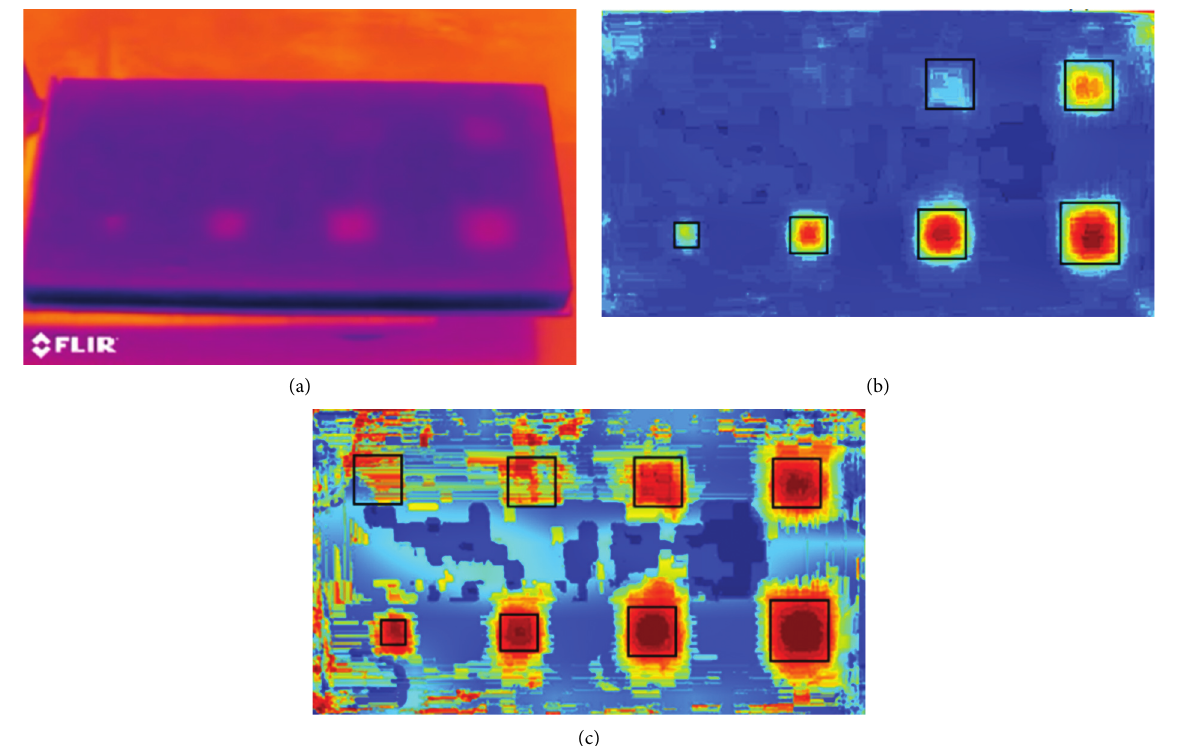
Figure 11: Comparison image enhancement of B. (a) B-before image enhancement. (b) B-CLAHE enhancement. (c) B-GHE enhancement.